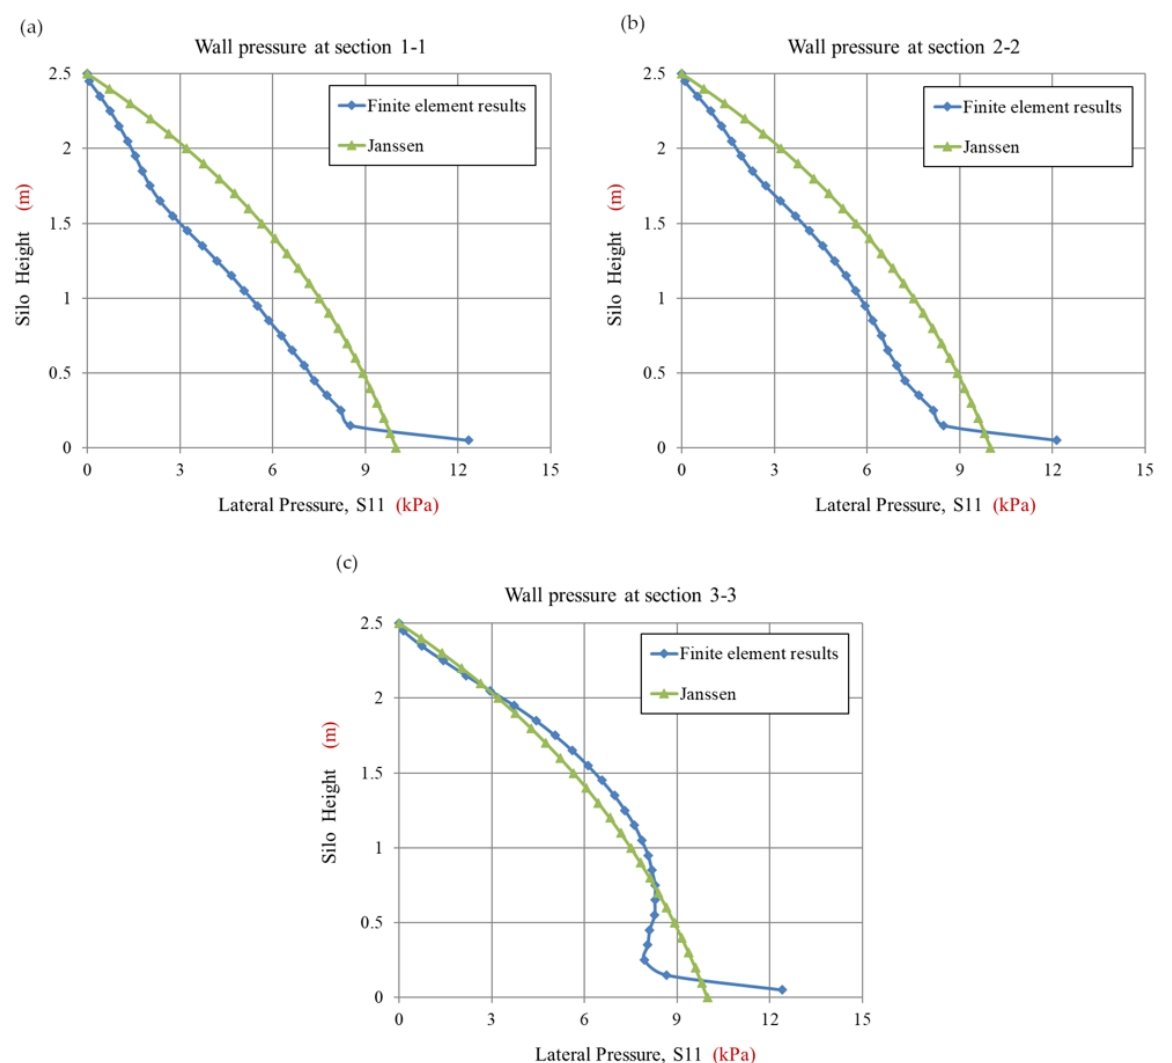
Figure 9. Comparison between lateral filling pressure of the finite element and Janssen predictions along the silo height in case of the flexible walled silo. ( a ) section 1-1: at mid-side of the wall; ( b ) section 2-2: at 0.35 m from silo center; ( c ) section 3-3: at 0.55 m from silo center.